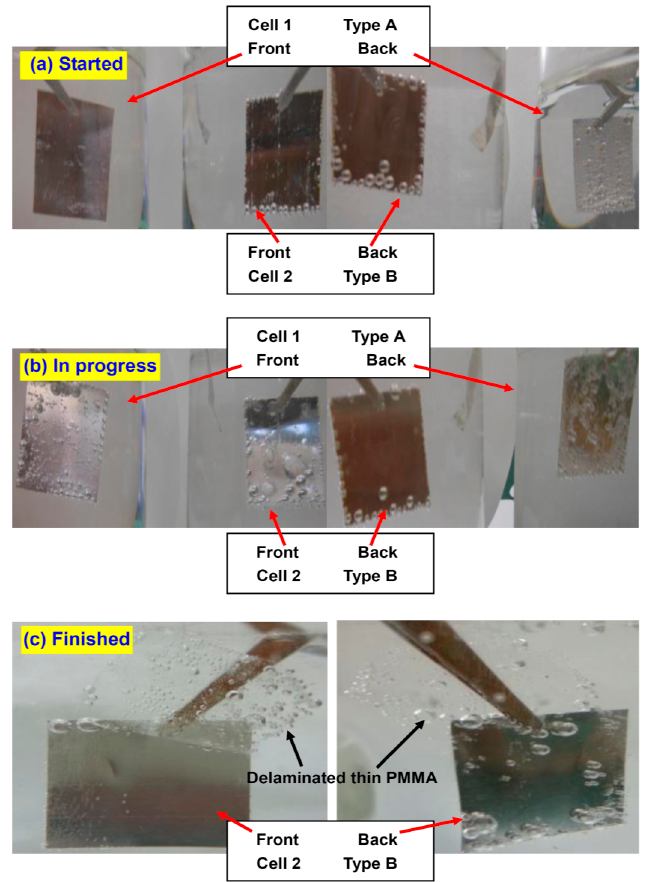
Figure 4. Photos of the samples where the experiment is ( a ) just started; ( b ) in progress and ( c ) already finished. The front side thin PMMA layer is entirely peeled off from the type B sample in cell 2 whereas remains undetached on the type A sample in cell 1. It is explained by the screening effect induced by the PMMA block at the backside of type B